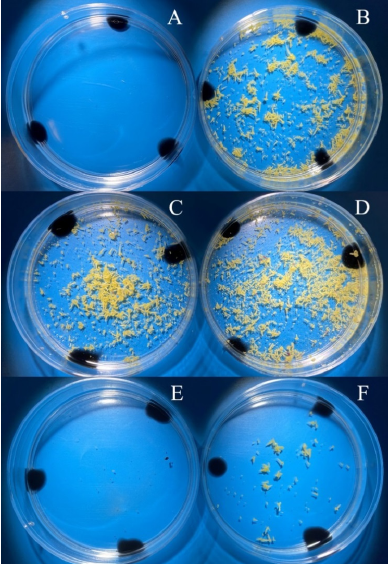
Figure 4. Yield of spring rapeseed embryoids ‘Ratnik’ at day 30 of culture depending on the method of isolation and linear size of buds. ( A , C , E )—microspore isolation № 2; ( B , D , F )—microspore isola ‐ tion № 3; ( A , B )—bud size 3.0–3.5 mm; ( C , D )—bud size 3.5–4.0 mm; ( E , F )—bud size 4.0–4.5 mm .